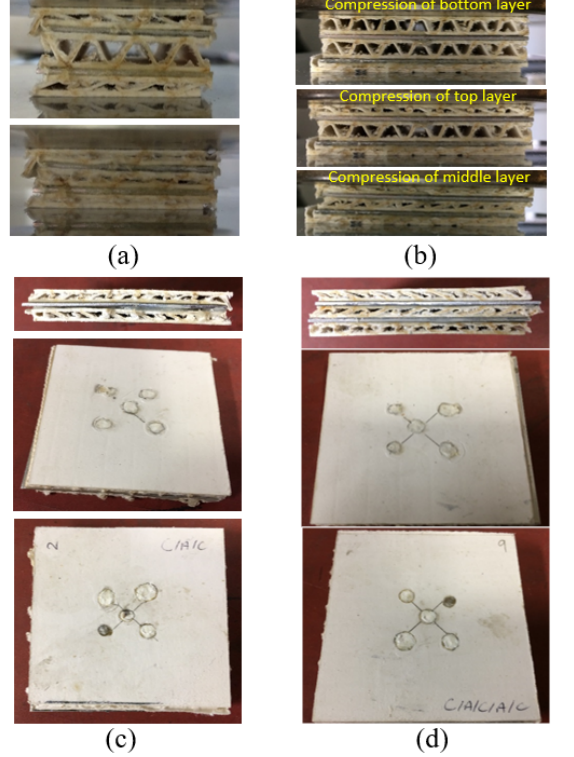
Figure 15: (a) Two-stage compression in a 30 mm × 30 mm CACAC sample showing the top and bottom cardboard layers compressed together first, followed by compression of the middle layer; (b) Three-stage compression in a 60 mm × 60 mm CACAC sample show- ing the bottom layer compressed first, followed by the top layer, and lastly the middle layer; (c) Side, top, and bottom views of